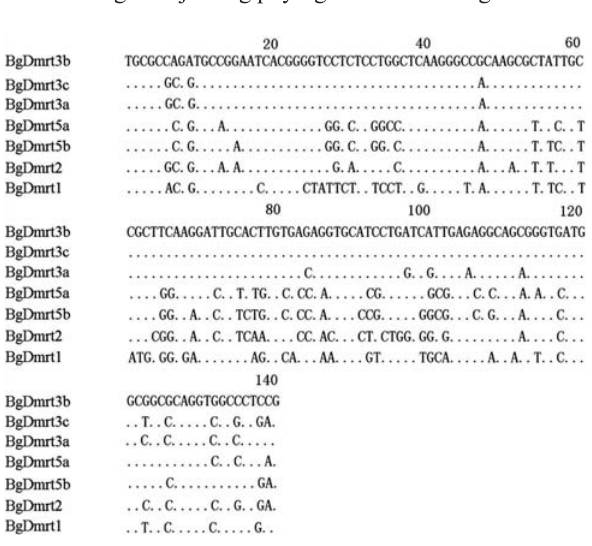
Figure 1 - The nucleotide sequences of seven doublesex/male abnormal 3 (dsx/mab-3 or DM) related transcription factor ( DMRT ) gene DM do- mains from Bufo gargarizans ( Bg ). Dots indicate identities with BgDmrt3b .